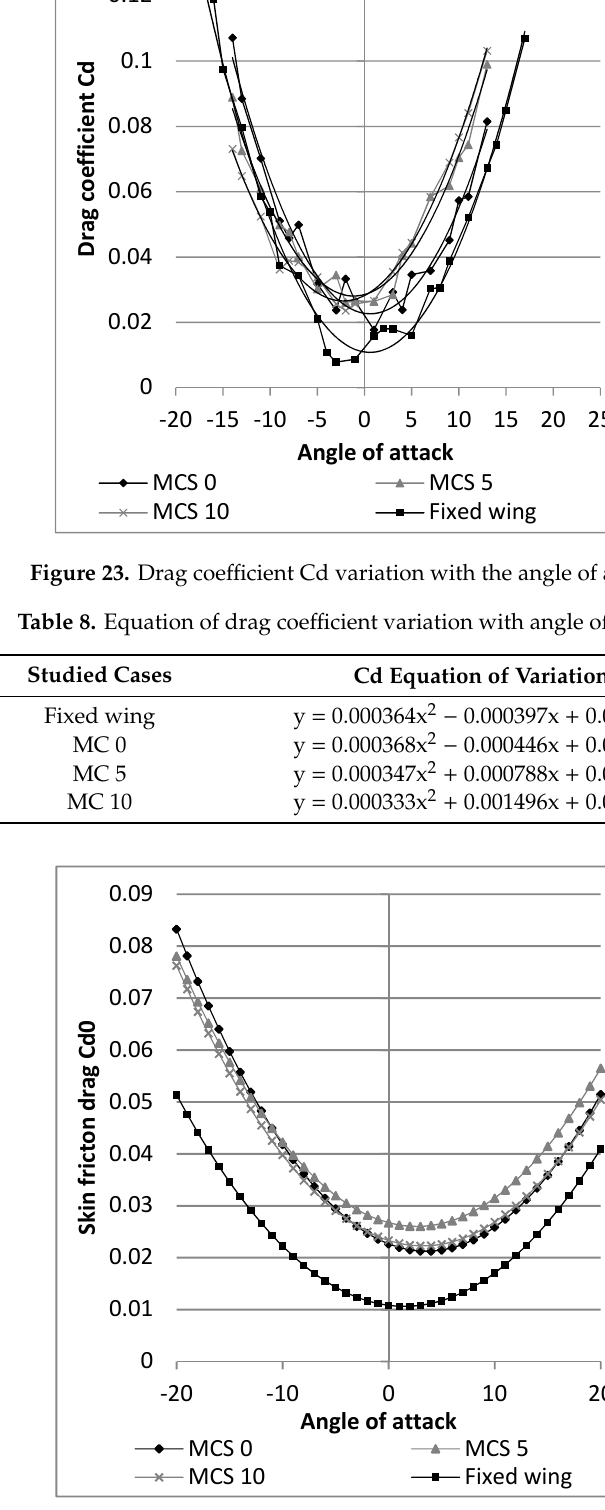
Figure 24. Skin friction drag variation with the angle of attack.